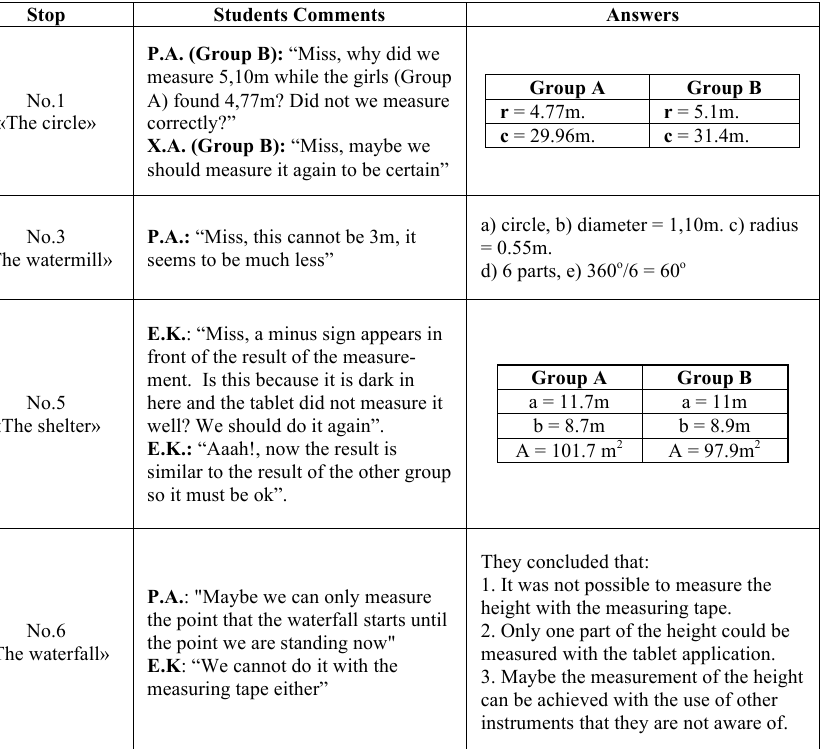
Table 3. Vignettes from the math trail